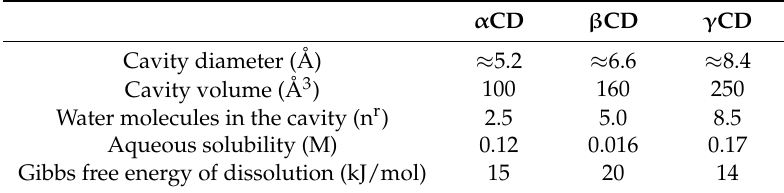
Table 1. Some physicochemical properties of the most relevant CDs ( α -, β -, and γ CD) at 25 °C.